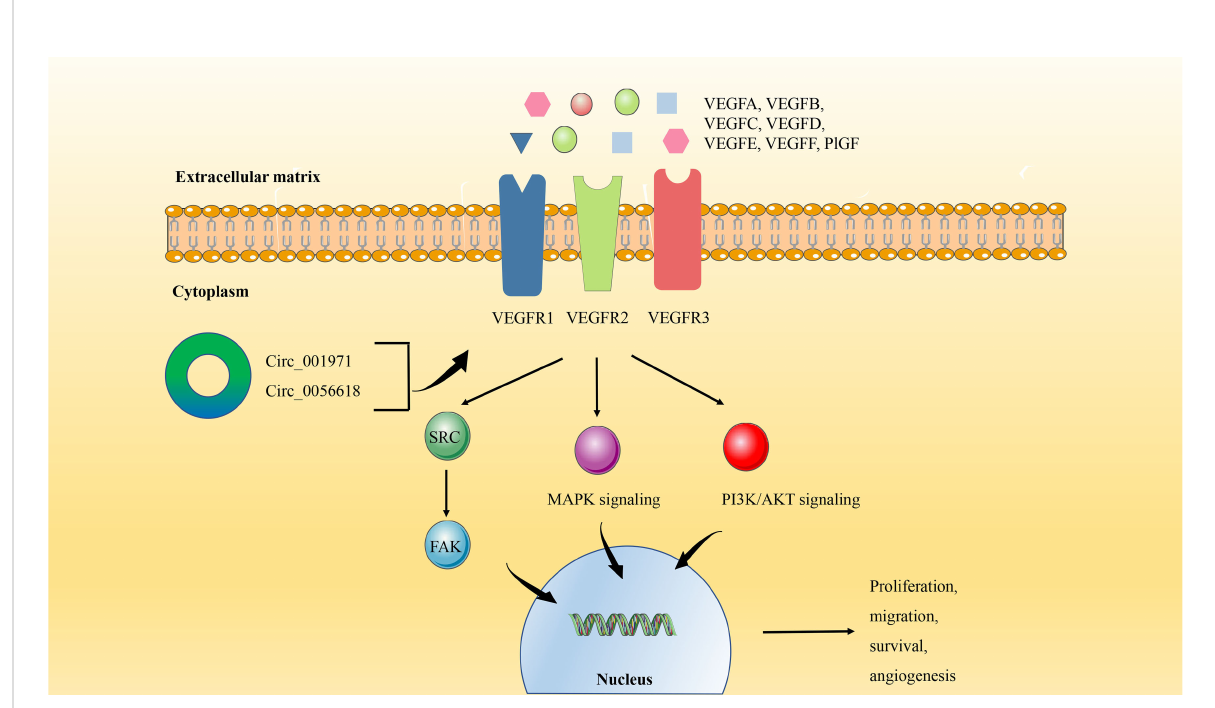
FIGURE 4 The circRNA/VEGF signaling axis in CRC. VEGF binds to tyrosine kinase cell receptors (VEGFR1-3) to activate VEGF signaling in endothelial cells. The activation of VEGF signaling can not only induce the protein expression of SRC kinase and FAK Focal adhesion kinase, but also trigger PI3K/ AKT and MAPK signal transduction. Finally, it regulates the process of angiogenesis, proliferation, migration, and